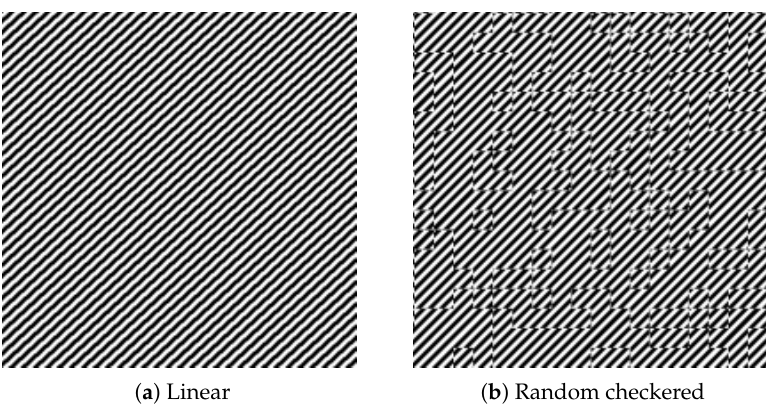
Figure 3. ( a ) Square segment of the pattern for a plane wave illumination. ( b ) Square segment of the pattern for a randomly checkered phase modulated